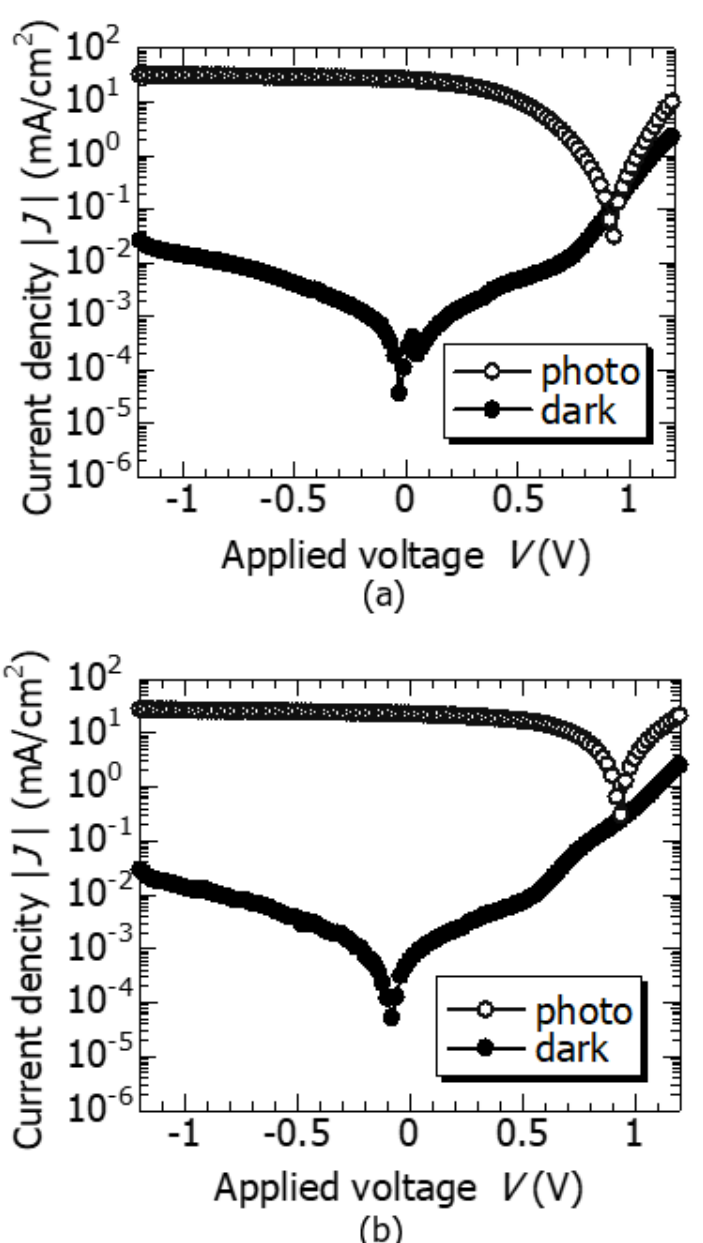
Figure 5. Device characteristics of photo-sensor without ( a ) and with PEIE ( b ) as electron injection layer using two-step method.